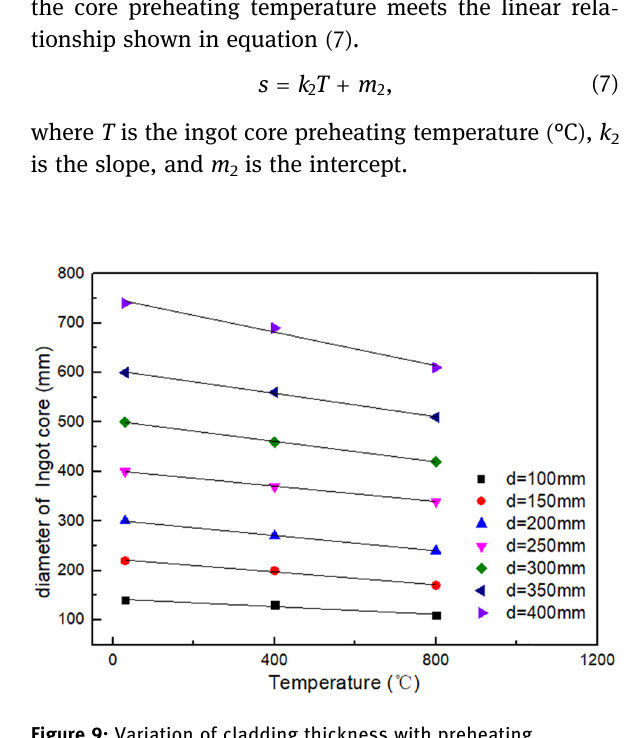
Figure 10: Surface melting rate of ingot core at di ff erent preheating